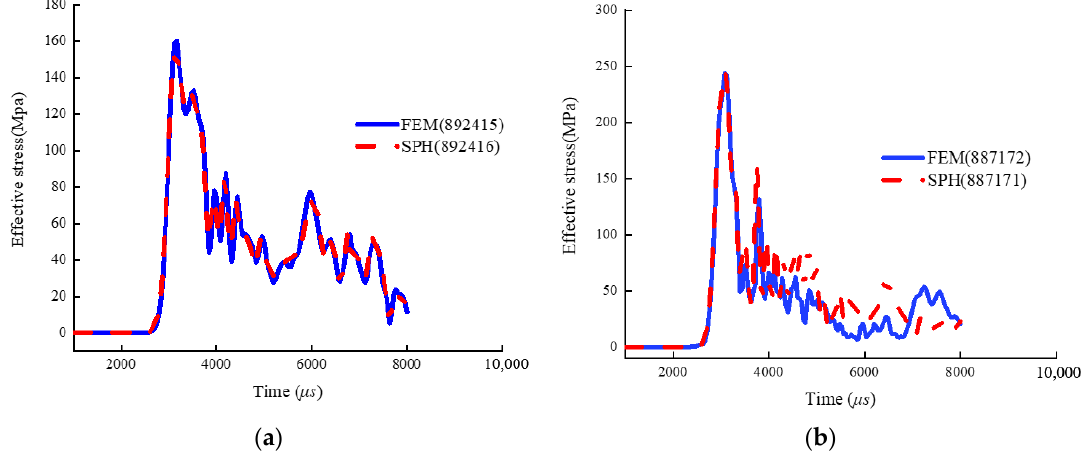
Figure 9. Comparison of effective stress curves at the interface. ( a ) Stress curve comparison of unit 982415 and unit 892416; ( b ) Stress curve comparison of unit 887172 and unit 887171.